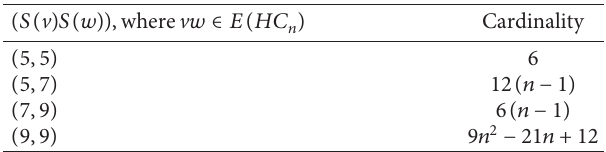
Table 2: Edge partitions of HC